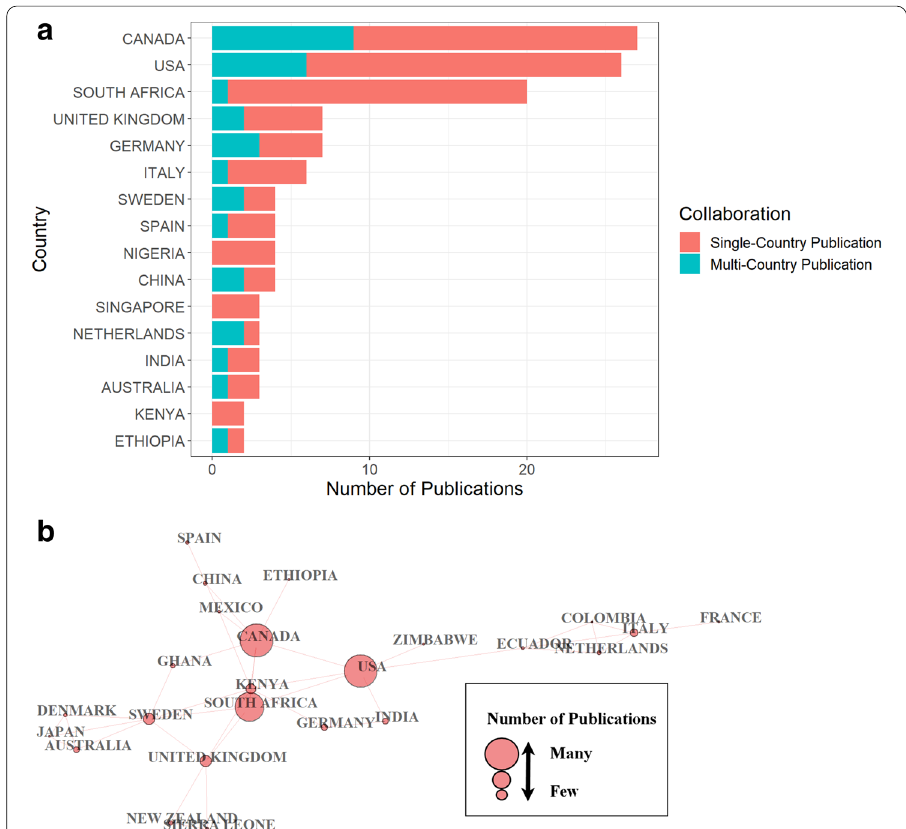
Fig. 3 a Publications by region. b Network of regional